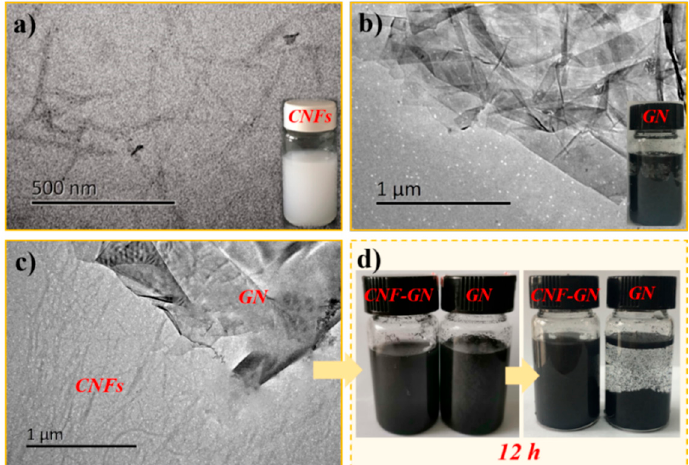
Figure 2. Transmission electron microscope (TEM) images of CNFs ( a ), GN ( b ), and GN-CNF nanocomplexes ( c ); ( d ) macroscopic pictures of pure GN and GN-CNF dispersions after a 12 h resting.